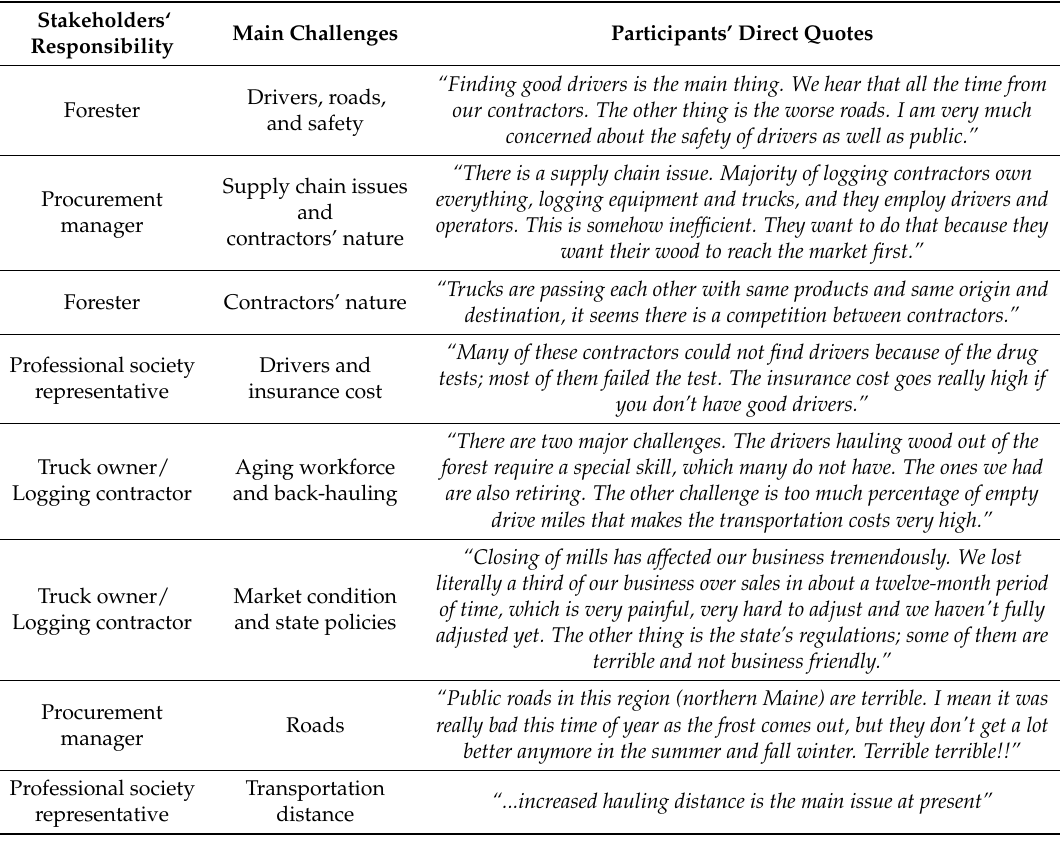
Table 3. Examples of the participants’ responses to the challenges faced by the forest trucking industry in